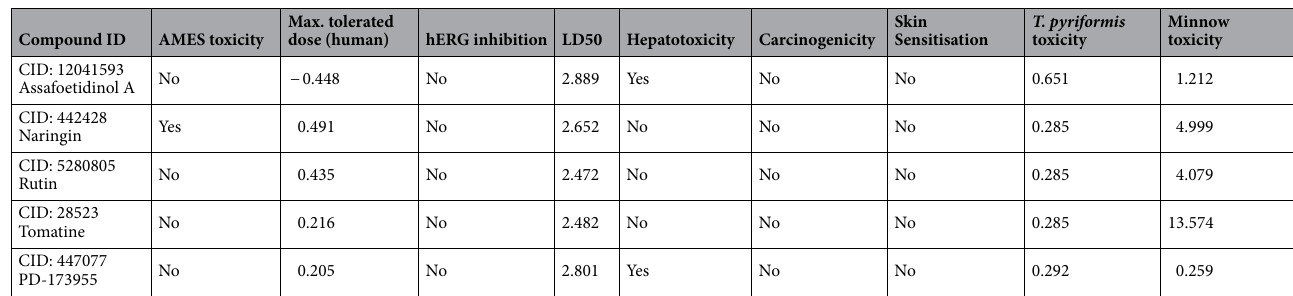
Table 6. List of the drug-induced hERG inhibition, AMES toxicity, carcinogens, Tetrahymena pyriformis (TP) toxicity, rat acute toxicity (LD 50 in mol/kg), and skin sensitisation along with Minnow toxicity of selected four